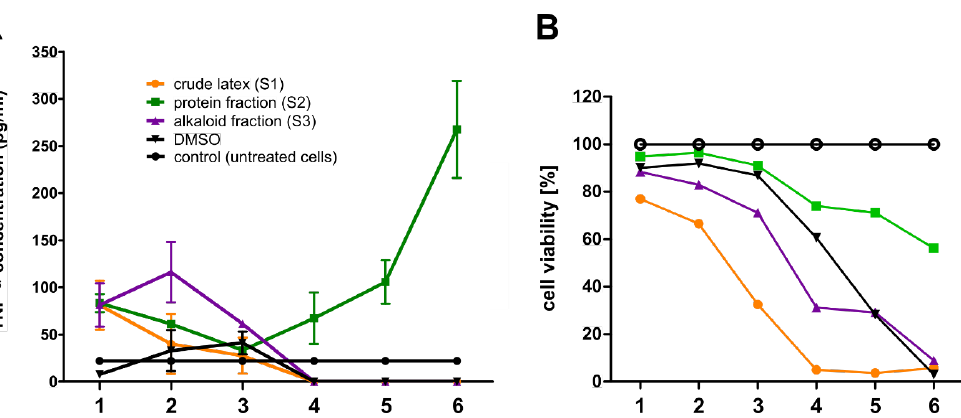
Figure 11. ( A ) Effect of crude C. majus latex (S1), protein fraction (S2), and alkaloid-rich fraction (S3) on tumor necrosis factor secretion by RAW 264.7 cells. Consecutive numbers (1 – 6) on the x axis correspond to different protein concentrations in the crude latex (S1) and protein fraction (S2) applied on cells: 1 = 1.6 × 10 − 4 mg/mL, 2 = 4.0 × 10 −4 mg/mL, 3 = 1.6 × 10 −3 mg/mL, 4 = 8.0 × 10 −3 mg/mL, 5 = 1.6 × 10 −2 mg/mL, 6 = 8.0 × 10 −2 mg/mL. In the case of alkaloid-rich fraction (S3), consecutive numbers (1 – 6) correspond to its different dilutions: 1 = 2 × 10 −4 , 2 = 5 × 10 −4 , 3 = 2 × 10 −3 , 4 = 10 −2 , 5 = 2 × 10 −2 , 6 = 10 −1 . They were obtained using series of dilutions from concentrated samples. The protein fraction (S2) stimulated the secretion of TNFα by macro phages at the level of 267.7 pg/mL while maintaining approx. 60% cell viability. LPS-treated cells (100 ng/µL) (positive control) secreted TNFα at a level of 213.6 μg /mL. ( B ) Simultaneous analysis of the effect of crude C. majus latex, alkaloid-rich fraction, and protein fraction on RAW 264.7 cell viability. Among the tested samples, the strongest cytotoxicity was shown for the crude latex and the alkaloid-rich fraction in the range of 8.0 × 10 −3 – 8.0 × 10 −2 mg/mL (numbers 4 – 6). The protein fraction showed the lowest toxicity to RAW 264.7 cells in all analyzed concentrations.